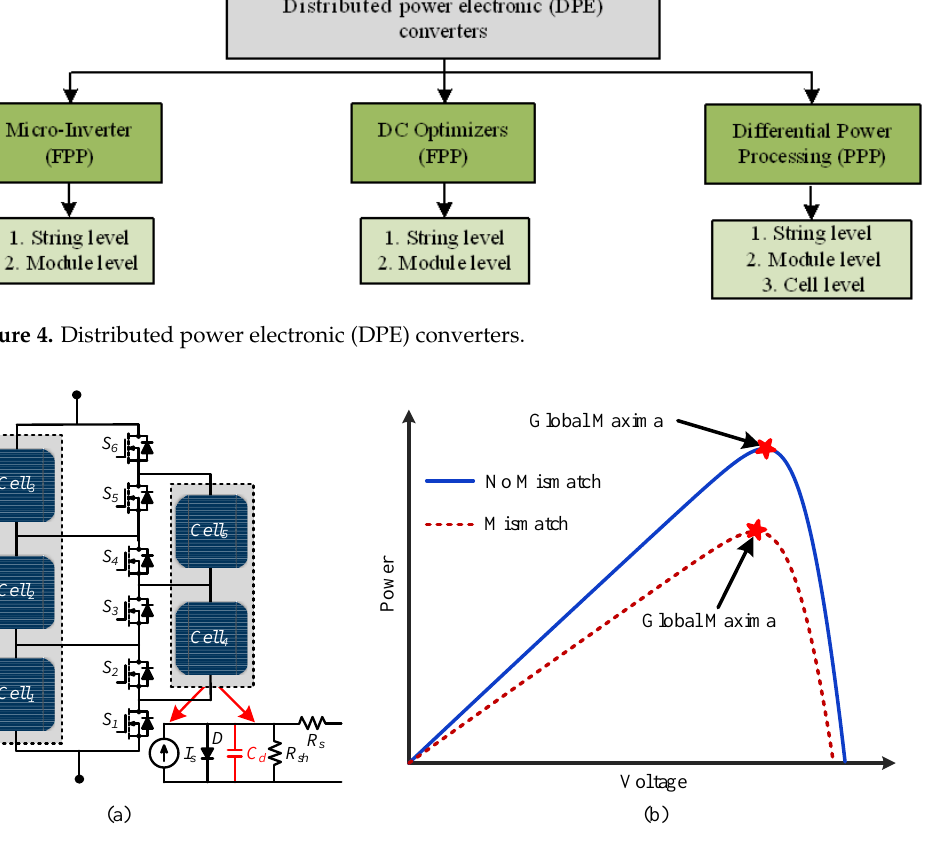
Figure 5. ( a ) Diffusion charge redistribution (DCR) DPP architecture; ( b ) power–voltage ( P-V ) characteristics during mismatch and without mismatch using [17].